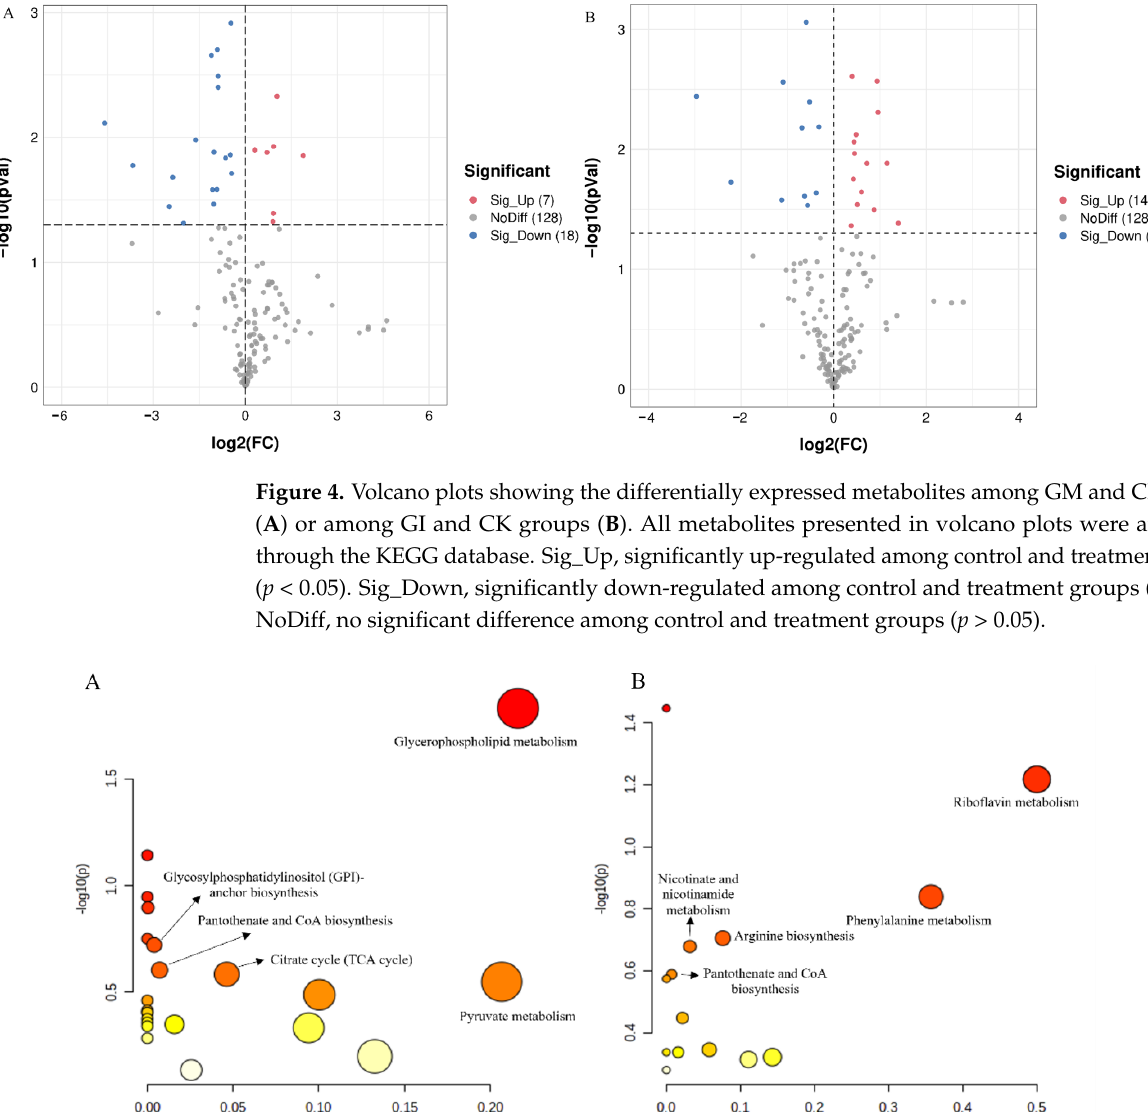
Figure 3. The principal components analysis (PCA, ( A )) and supervised partial least squared discri- minant analysis (PLS–DA, ( B )) of metabolite profiles in fat body of gypsy moth larvae.